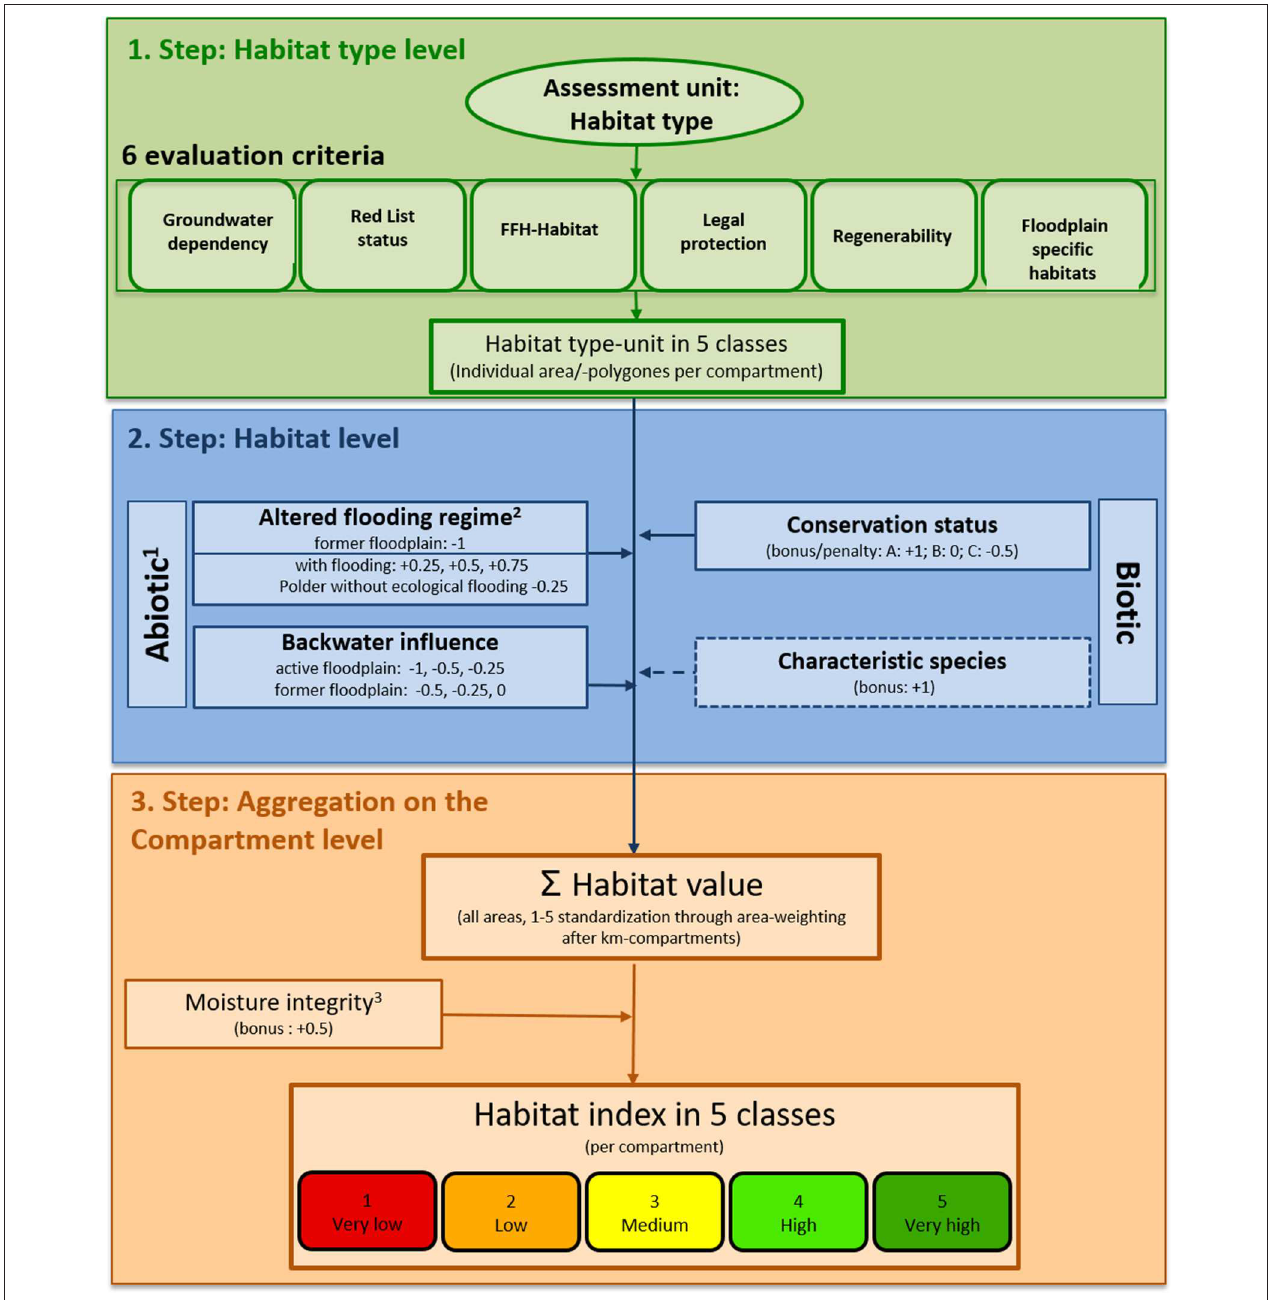
FIGURE 1 | Flow diagram of the assessment method of the habitat provision index. The method is based on three consecutive steps: the first on the general habitat type level on the base of six criteria, the second on the specific habitat level with several bonus points and penalties, and the last on the compartment level as aggregation on definite areas. 1) Penalty/bonus only for exclusive or medium floodplain habitat types [FS (floodplain specific habitats) = 3 or 5]. 2) Summer dykes or other areas protected by dams, flooding areas with controlled inflow structures or inflow swells, controlled polders. 3) Only for habitat types with FS = 5 (exclusive floodplain